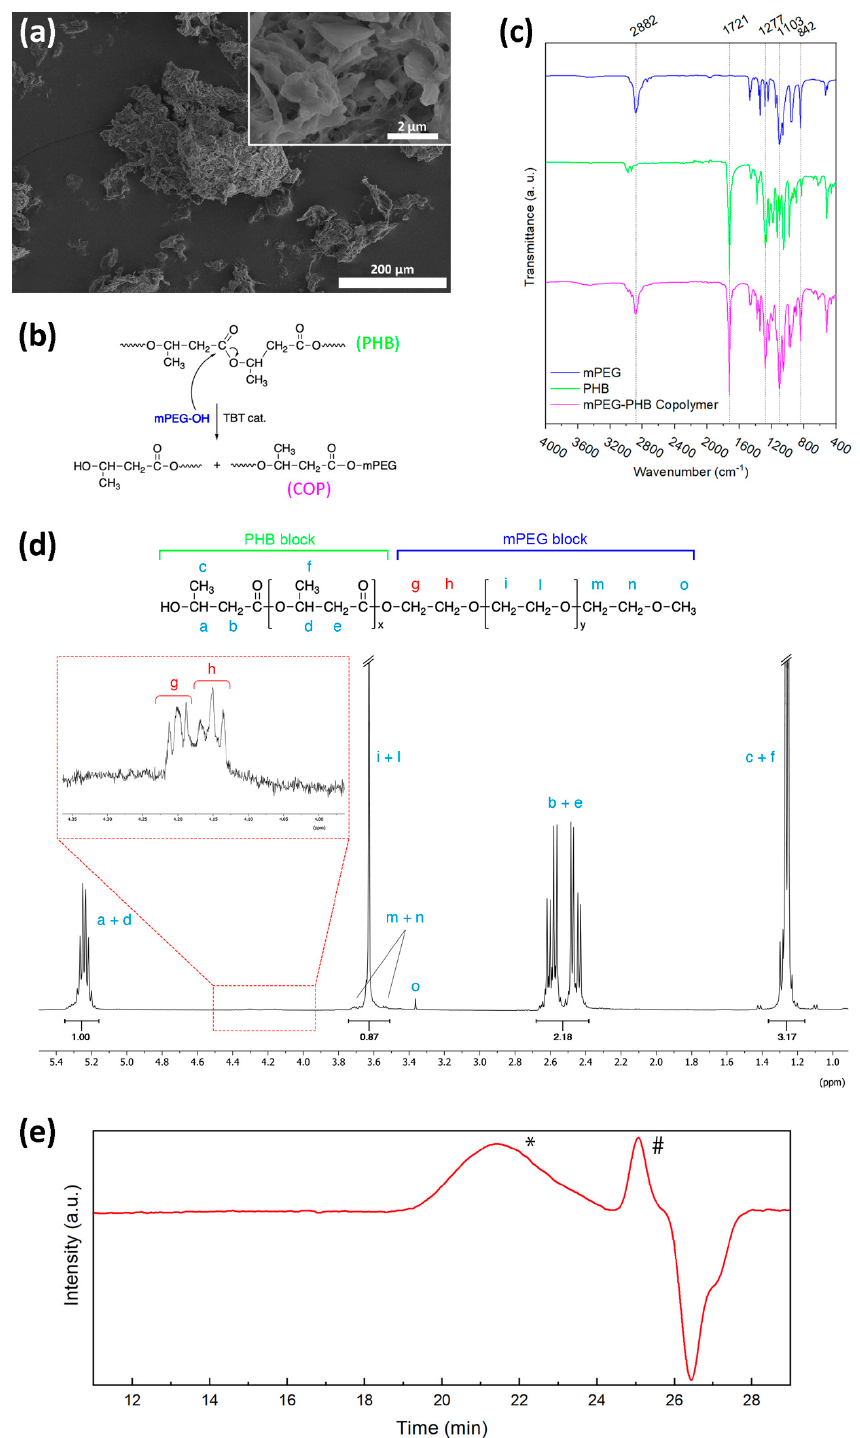
Figure 1. ( a ) FESEM micrographs showing the morphology of the NFC/PEG particles prepared by freeze-drying. ( b ) Scheme of the proposed reaction mechanisms for the copolymer synthesis as previously described by Ravenelle and Marchessault [26]. ( c ) FT-IR spectra of neat PHB, mPEG 1900, and the synthesized PHB–block–mPEG copolymer. ( d ) 1 H-NMR spectrum of PHB–block–mPEG copolymer and related assignments. The inset highlights the presence of triplets related to the two protons of the newly formed ester bond. ( e ) GPC chromatogram of the synthesized PHB–block–mPEG copolymer. * and # refer to the copolymer and reference peak (toluene),